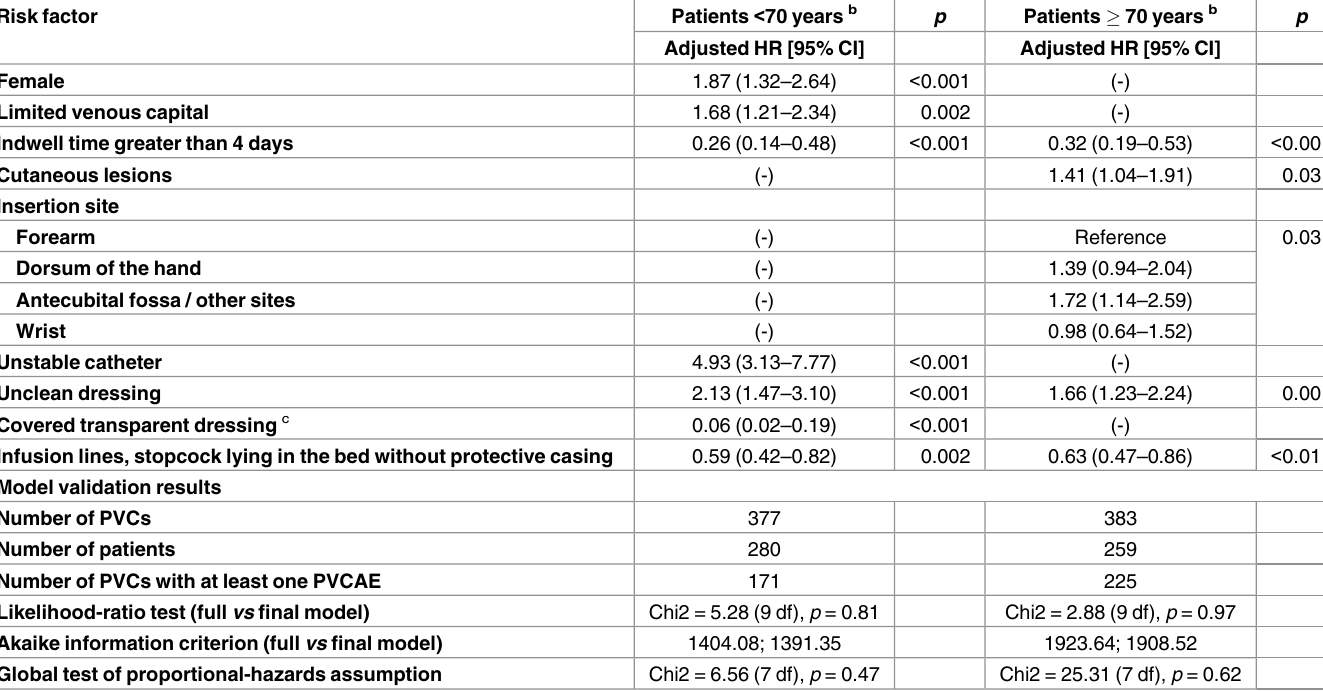
Table 7. Risk factors of PVCAEs according to age groups a , in multivariate